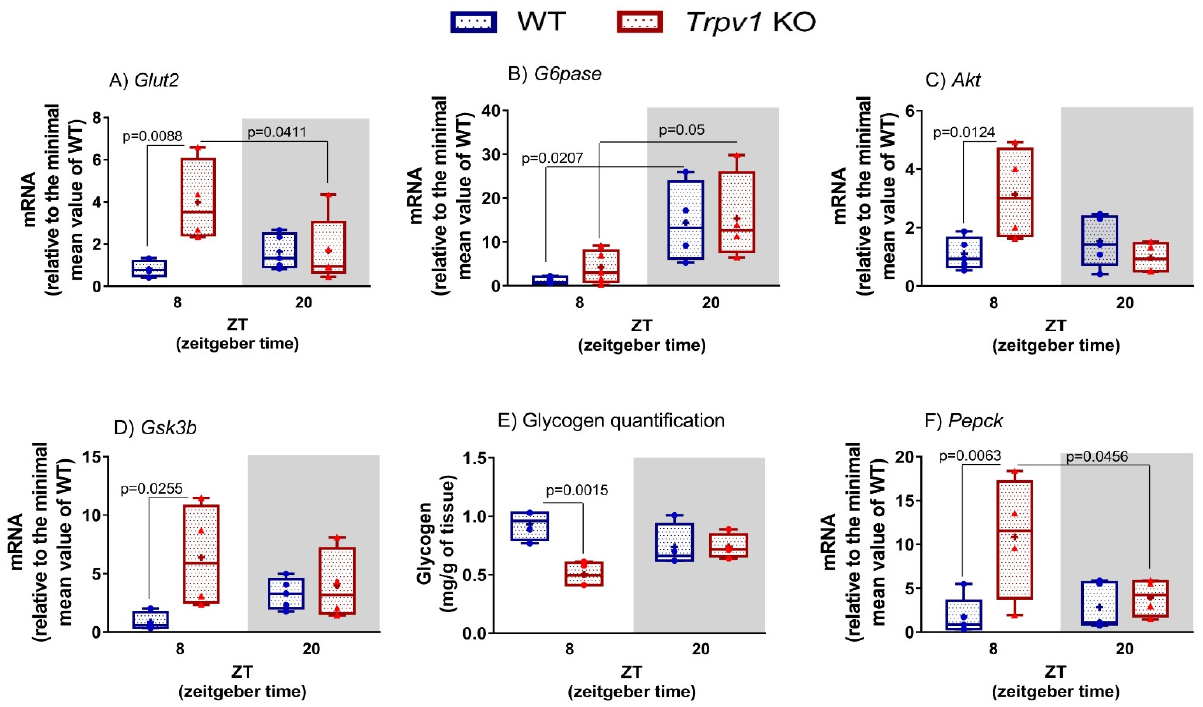
Figure 2. Hepatic glucose metabolism in the absence of TRPV1 channels. ( A – D , F ) Relative transcripts of hepatic genes related to glucose metabolism in C57BL/6J WT and Trpv1 KO mice at ZT8 (physiological fasting) and ZT20 (eating phase). Results of mRNA quantification are shown as median, quantiles, and maximum and minimum expression values of gene transcripts normalized by 18S ribosomal RNA and expressed relative to the minimum mean value of WT mice. + represents the mean ( n = 4–5). Significant differences between ZTs and between genotypes were demonstrated by two-way ANOVA, followed by the Bonferroni post-test. ( E ) Hepatic glycogen quantification is expressed as mass (mg/g of tissue).